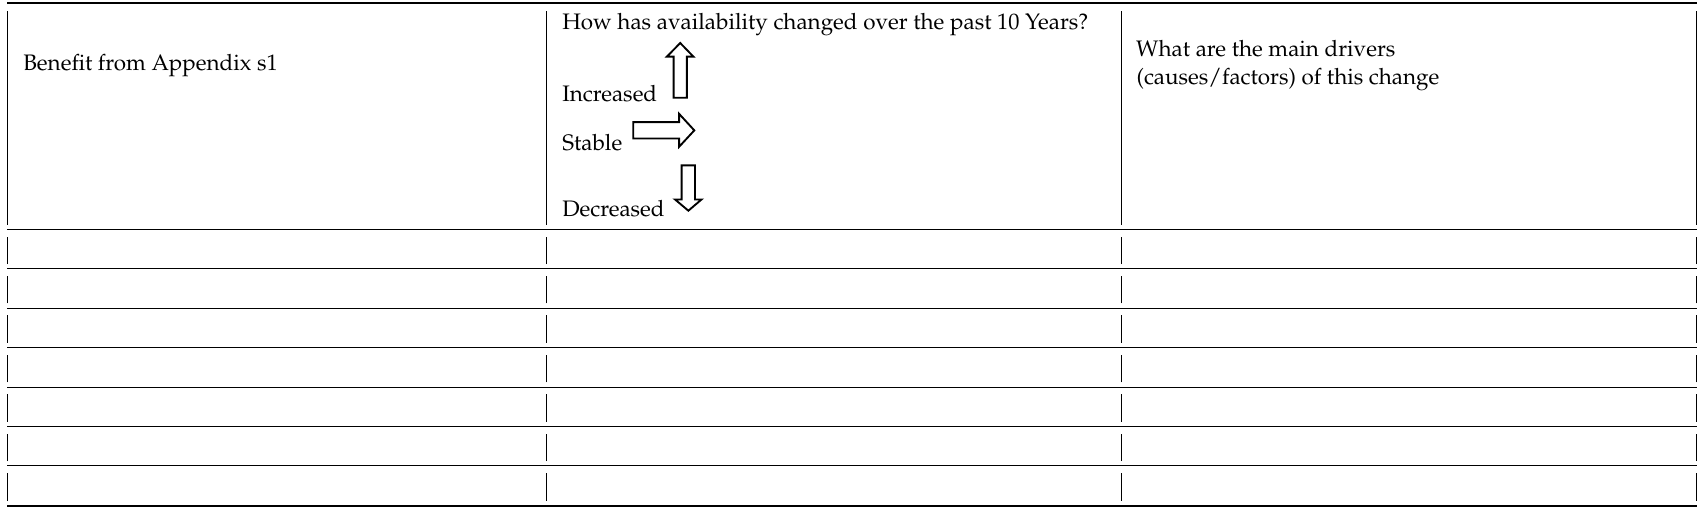
Table A3. The questionnaire table which was used to discover trends in changes of priority ES during the recent